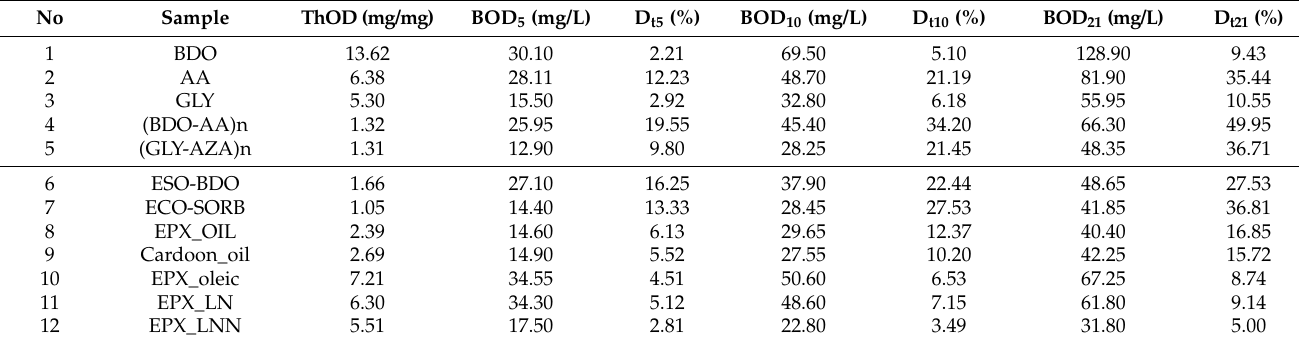
ment, along with the ThOD values of the monomers and oligoesters considered for